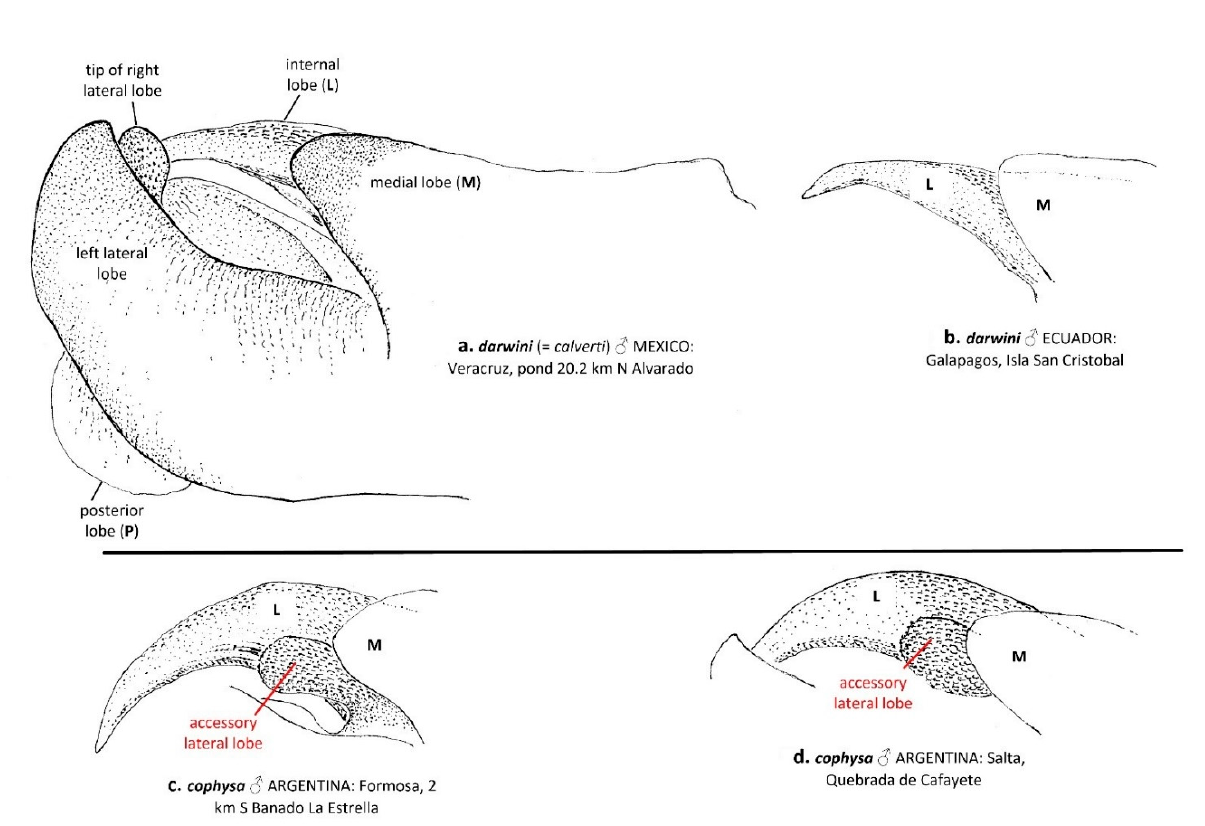
Figure 2. Lateral view of the male vesica spermalis of T. darwini (senior synonym of T. calverti , stat. rev.; a , b ) and T. cophysa ( c , d ), showing the accessory lateral lobe present in the latter, a characteristic that allows for discrimination between both species. Note that the left lateral lobe, the posterior lobe and the tip of the right lateral lobe appear only illustrated in a.